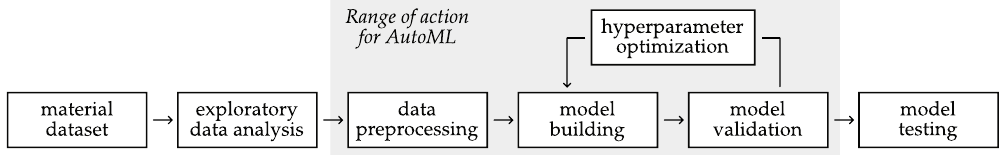
Figure 1. Data processing pipeline for a typical data mining workflow in materials design, starting with a material dataset and ending with model testing. Steps within the highlighted space can be automated by use of AutoML